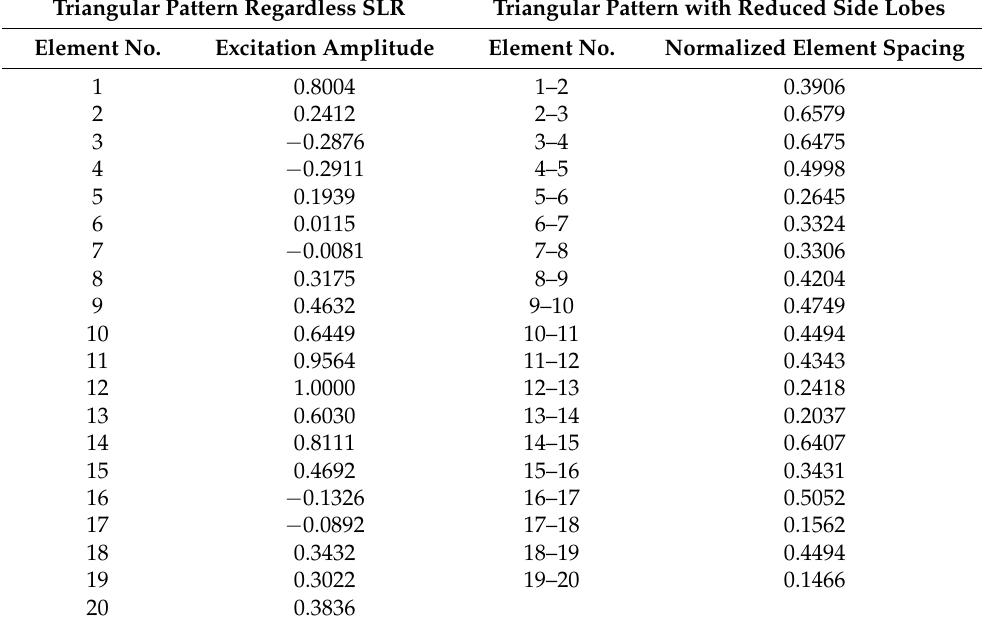
Table 8. The best normalized value of the amplitude of the excitation current and element spacing with respect to λ using FKE for triangular